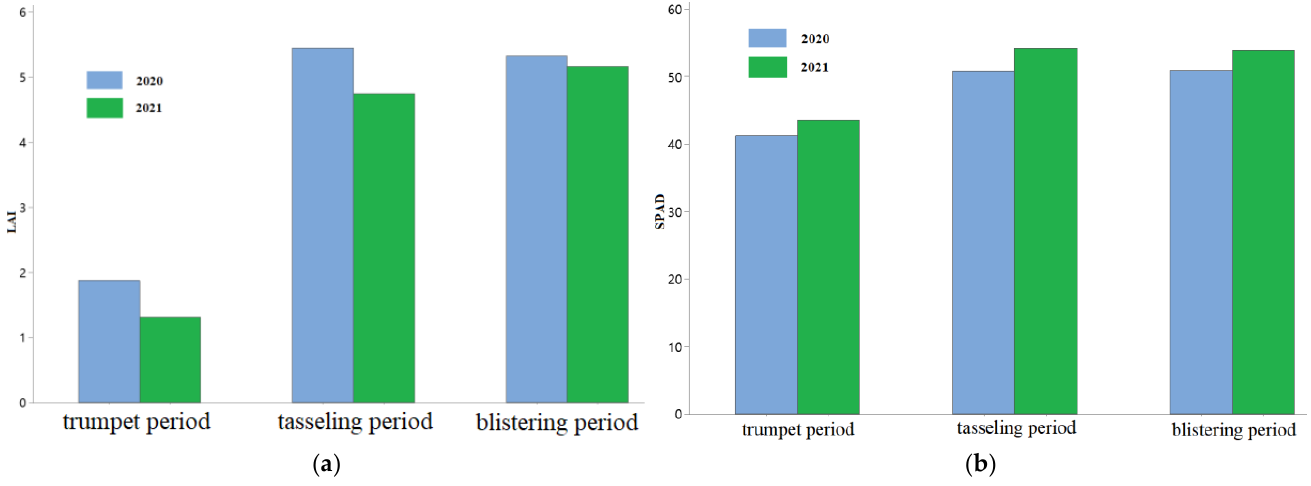
Figure 8. The change trend of LAI and SPAD in two years. ( a ) The change trend of LAI in two years. ( b ) The change trend of SPAD in two years.